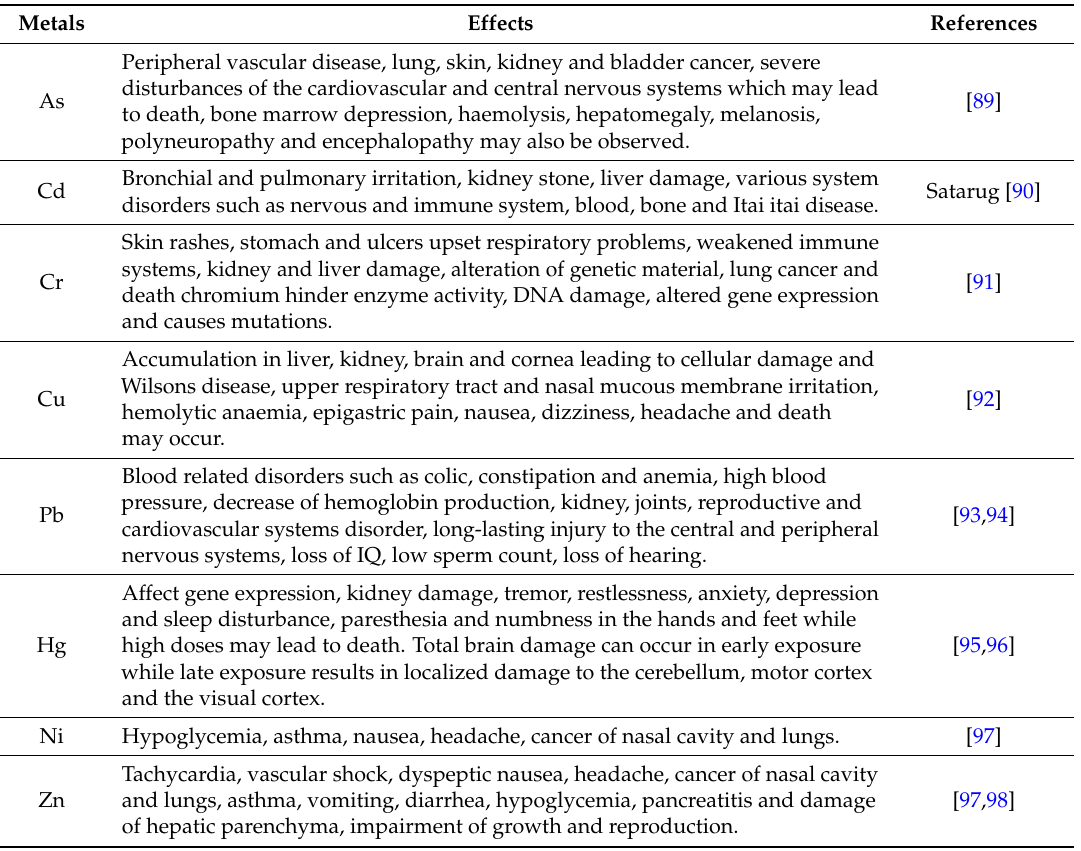
Table 1. Effects of heavy metals on human health.